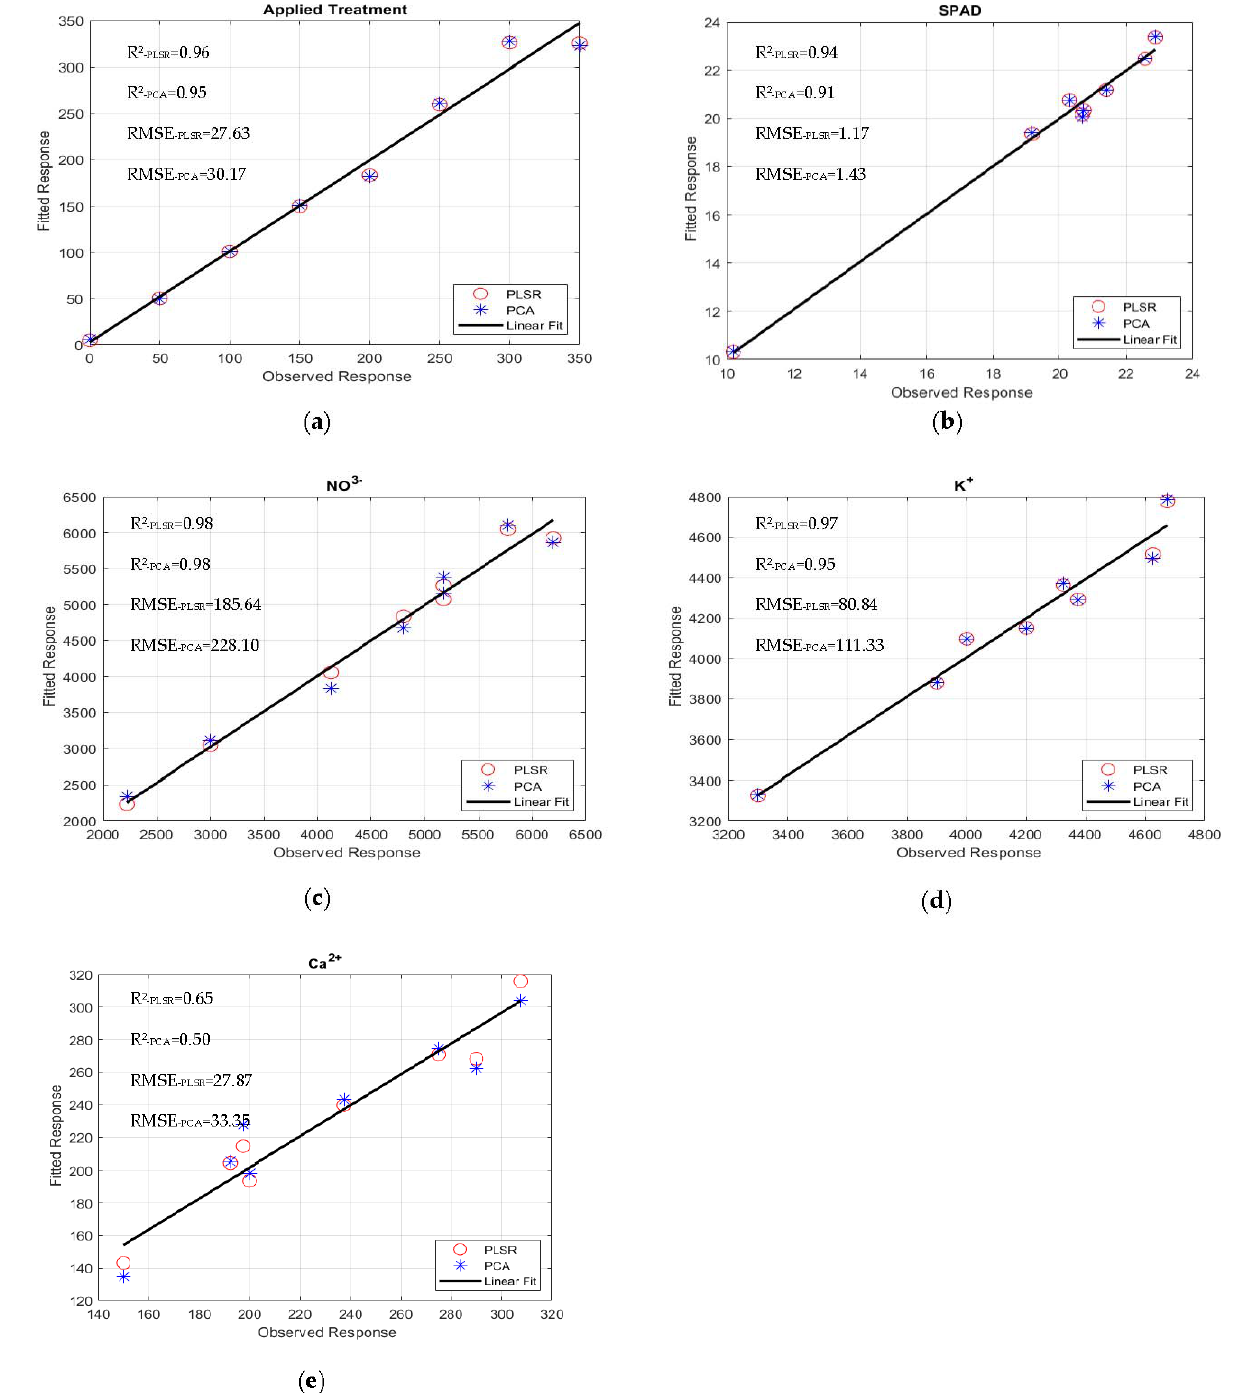
Figure 7. Observed and fitted (predicted) response (Black Seeded Simpsons): ( a ) applied treatment, ( b ) SPAD, ( c ) NO 3 − , ( d ) K + , and ( e ) Ca 2+.